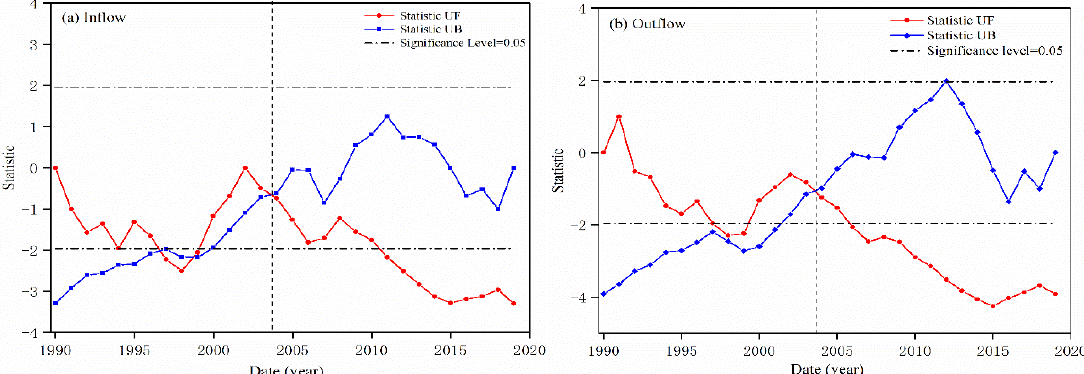
Figure 5. The Mann-Kendall (M-K) method test of the inflow ( a ) and outflow ( b ) in Erhai Lake. A positive UF value indicates that the water level is increasing, and a negative UF value indicates that the water level is decreasing. If the UF and UB curves intersect between the significance values, it indicates that the water level has changed suddenly at this time.